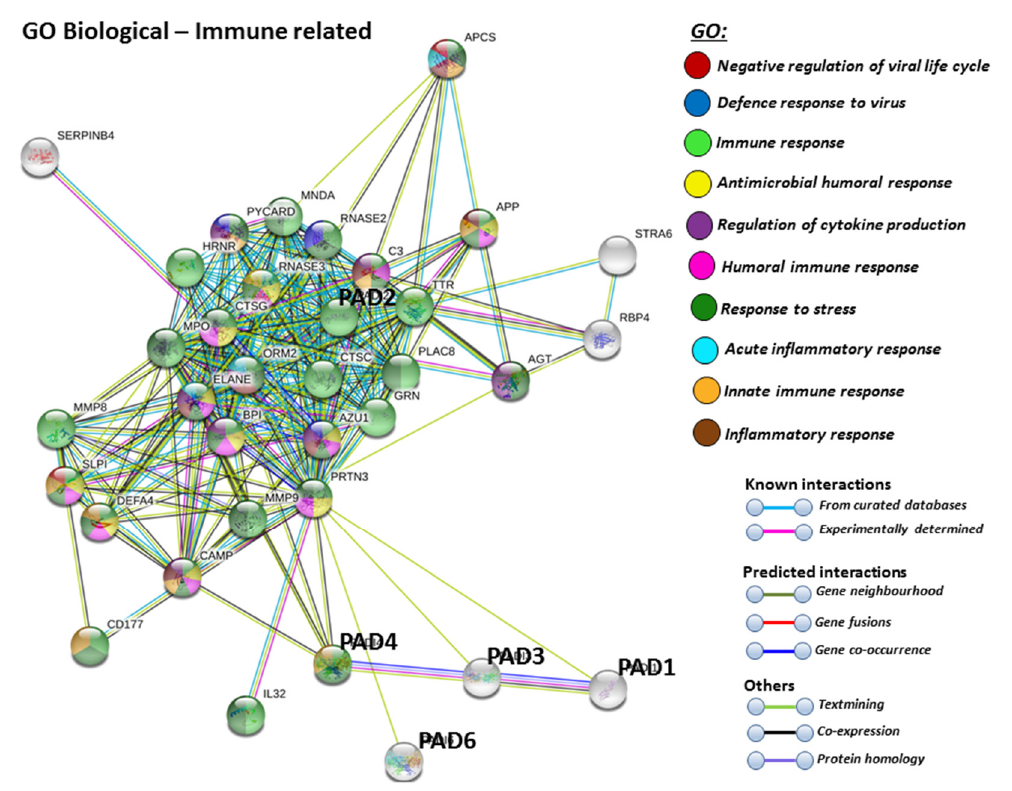
Figure 4. Biological GO (gene ontology) pathways for all human PAD isozymes, relating to immunity. Immune related GO biological pathways are highlighted for protein–protein interaction networks of binding partners with all PAD isozymes (PAD 1,2,3,4,6) as a group. Colour code for the di ff erent pathways is shown within the figure. Individual coloured lines represent specific protein interactions that have been identified through interactions that are known (referring to experimentally determined connections and curated databases), through interactions that are predicted (referring to gene fusion, gene neighbourhood, gene co-occurrence) or through interactions identified via text mining, co-expression or protein homology (please refer to the colour key provided in the figure for the di ff erent connective lines) (PPI enrichment p -value: < 1.0 × 10 − 16 ).